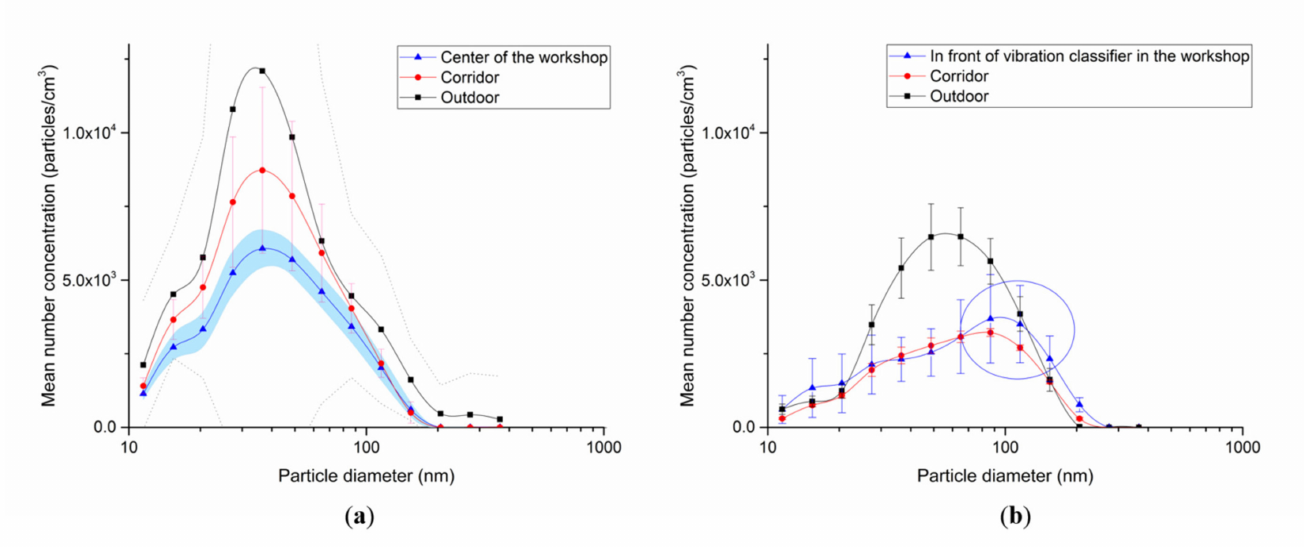
Figure 2. Mean particle size distribution measured bythe scanning mobility particle sizer (SMPS) on the ( a ) first and ( b ) third days, according to measurement points. The error bars, fill areas under curve, and dotted lines were standard deviations (SD). The SD of the outdoor number concentration on the first day is very large, and thus, is partially cut off in the